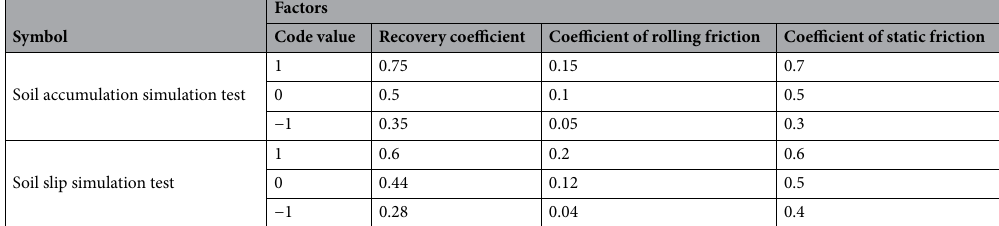
Table 2. Simulation test factor level coding.